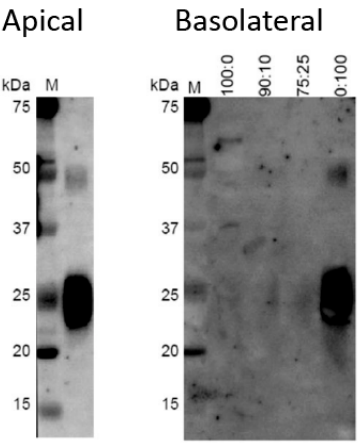
Figure 6. Epithelial transport of PP3 across Caco-2/HT29-MTX monolayers. Cells were grown at different Caco-2:HT29-MTX proportions on transwell membranes. PP3 was added to the apical compartment of the monolayers, and after 2 h, apical and basolateral medium was analysed by Western blotting using polyclonal anti-PP3 IgG. The Western blot of the apical sample is representative of all Caco-2:HT29-MTX proportions. For basolateral samples, the Caco-2:HT29-MTX proportions are given above the gels. The blots are representative of two individual experiments.